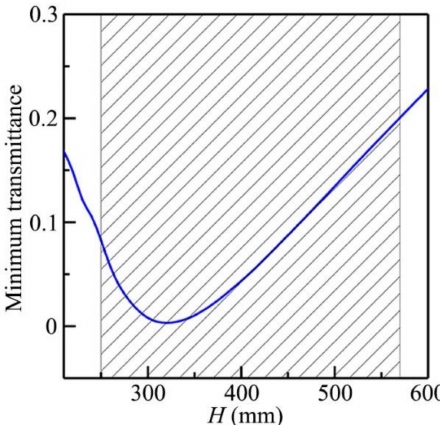
Figure 5. Simulated minimum transmittance spectrum through the open barriers with different values of H